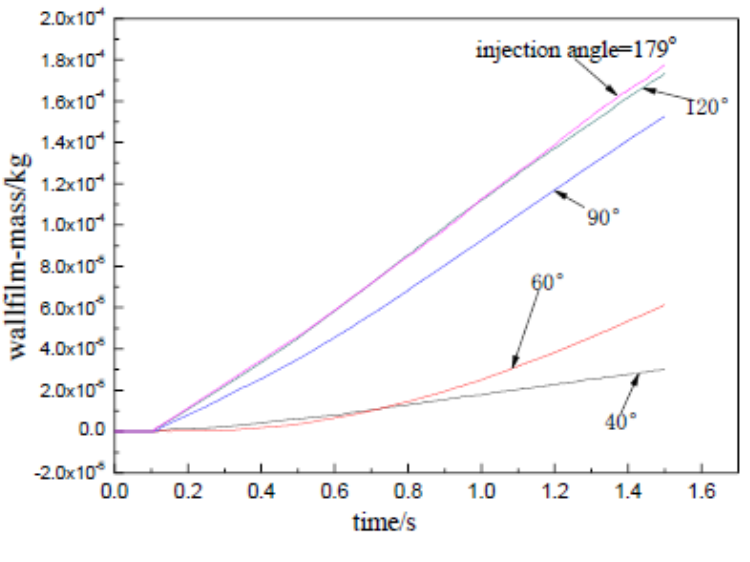
Fig. 10 Comparison of wallfilm mass at different injection